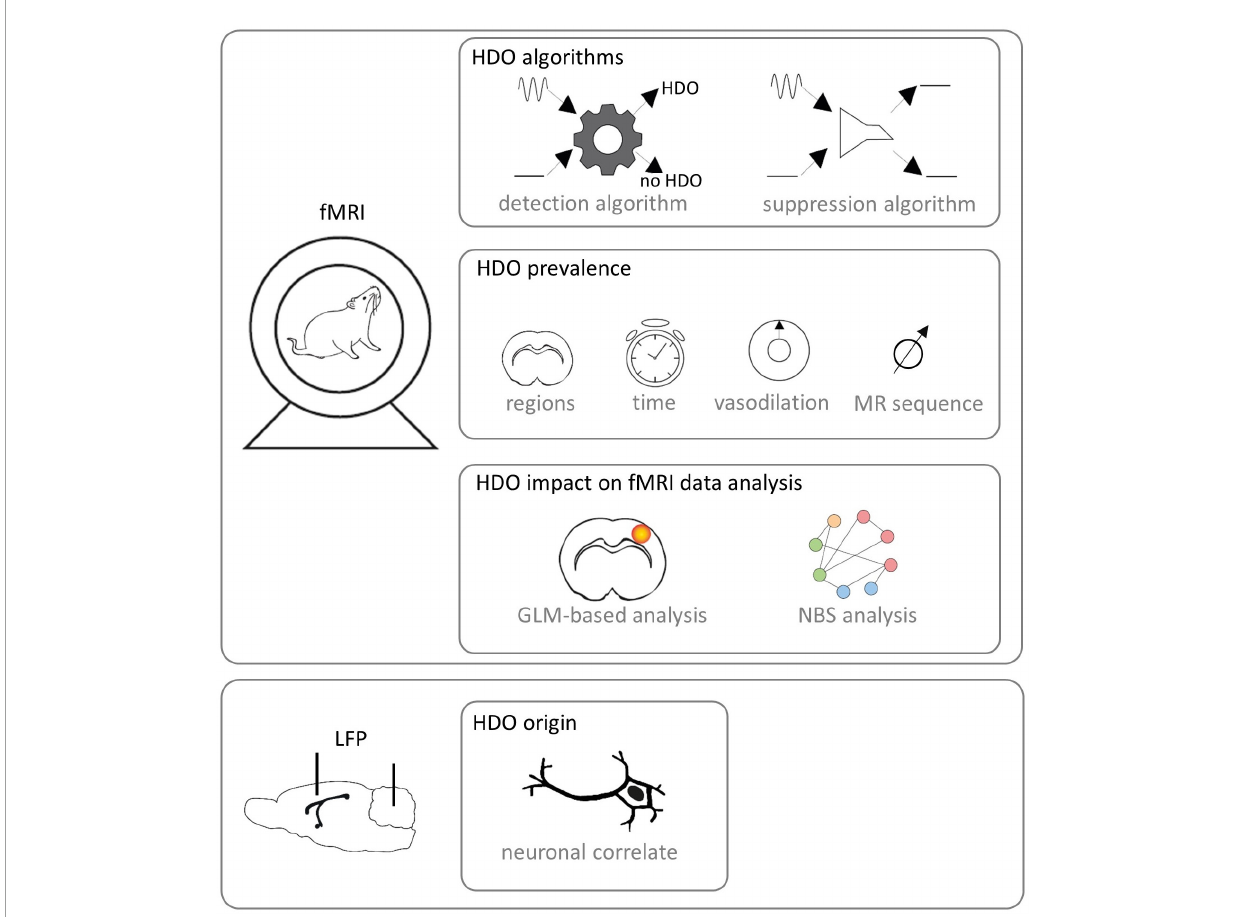
FIGURE1 Study design. fMRI was performed on Fischer rats. Algorithms for detection and suppression of HDO were developed. Afterward, HDO prevalence was investigated using the detection algorithm. In detail, it was examined in which brain regions and after which time HDO occurred after switching from ISO anesthesia to MED sedation. Further, the effect of vasodilation was studied and it was examined whether HDO occur in both SE-EPI and GE-EPI scans. Subsequently, the impact of HDO to GLM-based analysis and NBS analysis of fMRI data was examined using the developed algorithms. Additionally, LFP signals were recorded with implanted electrodes for examination whether HDO have a direct neuronal